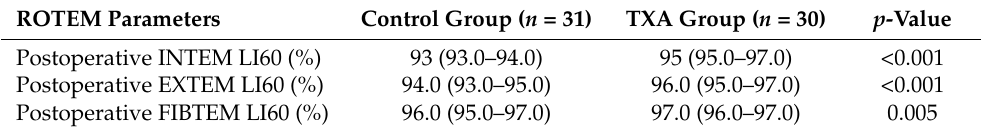
Table 5. Altered postoperative ROTEM parameters between the two groups.